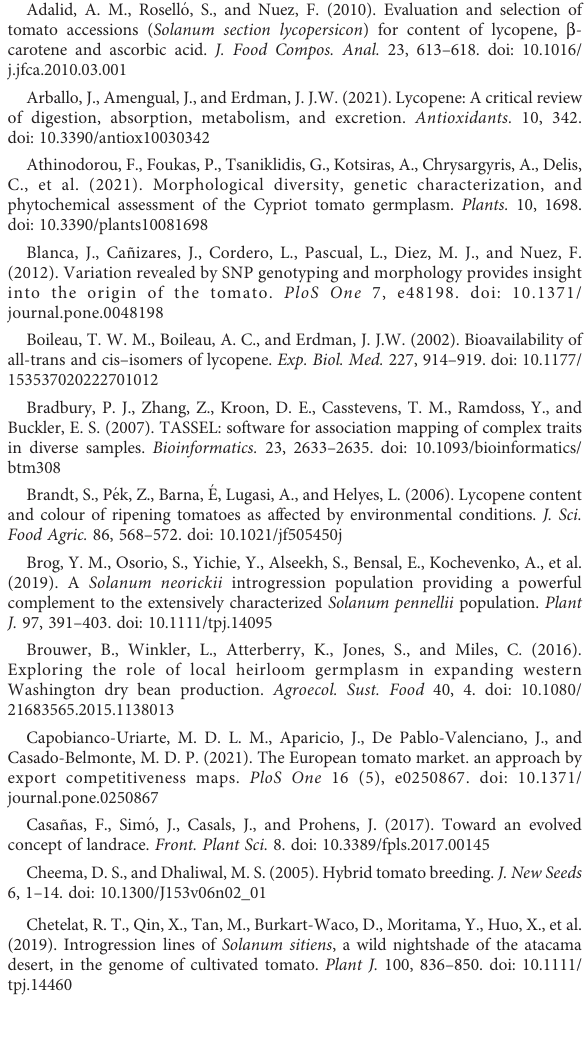
SUPPLEMENTARY FIGURE 2 Heterozygosity level based on SNP data for the 60 accessions studied. SUPPLEMENTARY FIGURE 3 Evaluation of the best grouping number (K) of the Bayesian clustering analysis using the Evanno ’ s method. (a) Plot of mean likelihood L(K) and variance for 5 independentrunsforeachvalueofK,forK=2 – 10.(b)Evanno ’ splotgenerated by STRUCTURE HARVESTER for the detection of the true number of clusters (themostlikelyvalueofK).c)TablewithdetailedvaluesforeachK.Thehighest valuewasatK=2,indicatingthatthesetstudiedlikelyforms2sub-populations. SUPPLEMENTARY FIGURE 4 Quantile-Quantile (QQ) plots of observed versus expected P -values using GLM-naive, GLM-PCA and GLM-Q models for b -carotene (blue line) and fruit weight (green